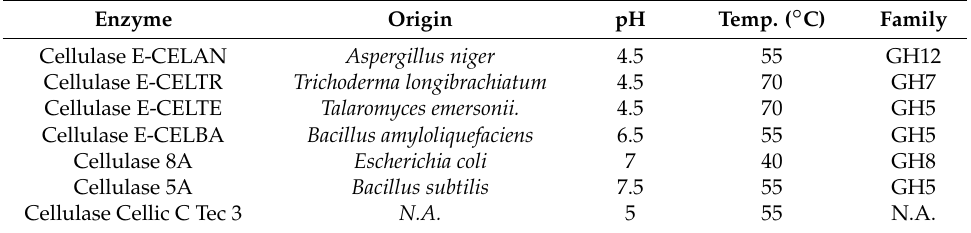
Table 4. Cellulases used for degradation of deacetylated cellulose acetate with their optimal conditions and origin. Family classification follows the Carbohydrate-Active Enzymes Database. Enzyme Origin pH Temp. ( ◦ C)